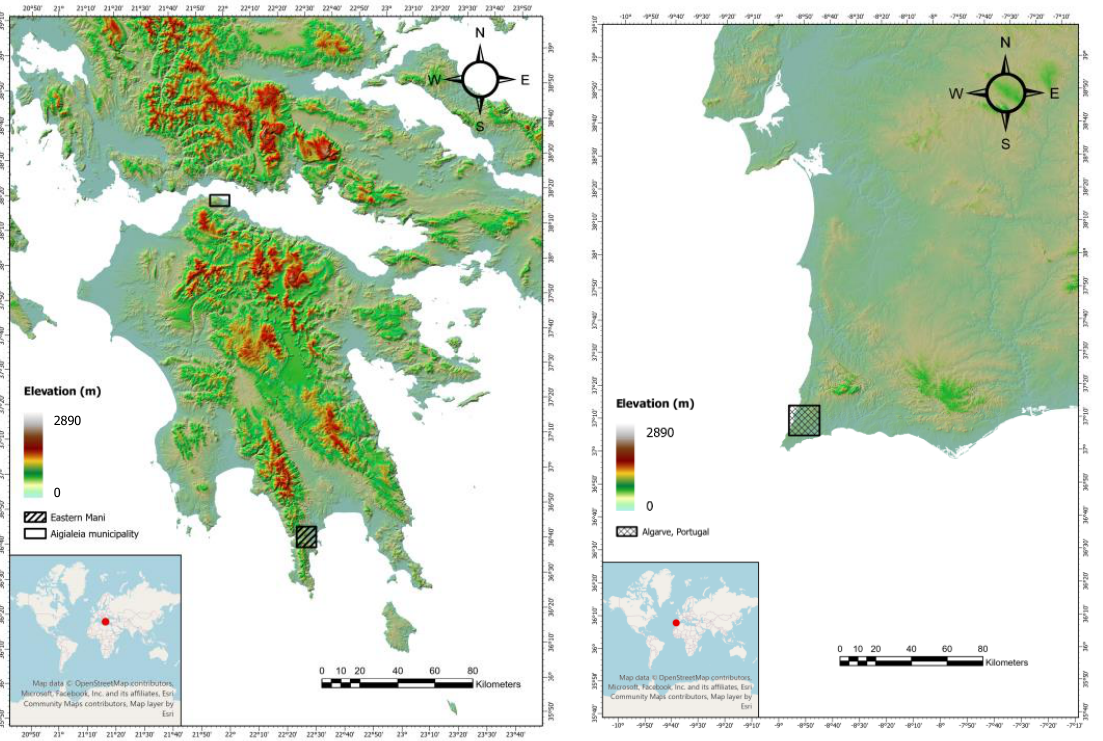
Figure 1. Maps of the three study areas: Aigialeia Municipality and Eastern Mani in Greece ( left ) and Algarve in Portugal ( right ) (on top of the Hillshaded Relief Map, which was produced from EU-DEM v1.1 [46]).